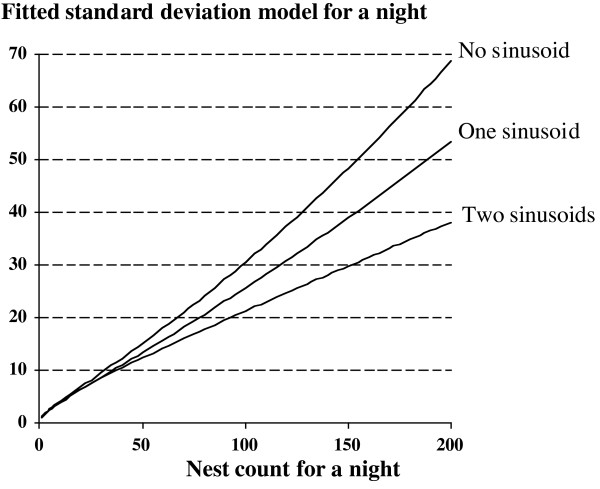
Standard deviations of the fitted model with zero, one or two sinusoids added to the global pattern.